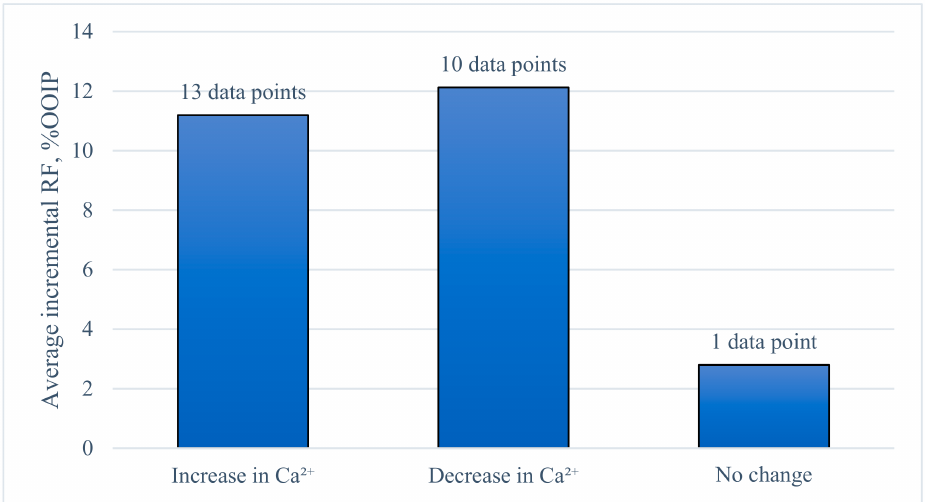
Figure 6. Average incremental RF vs. effluent Ca 2+ concentration